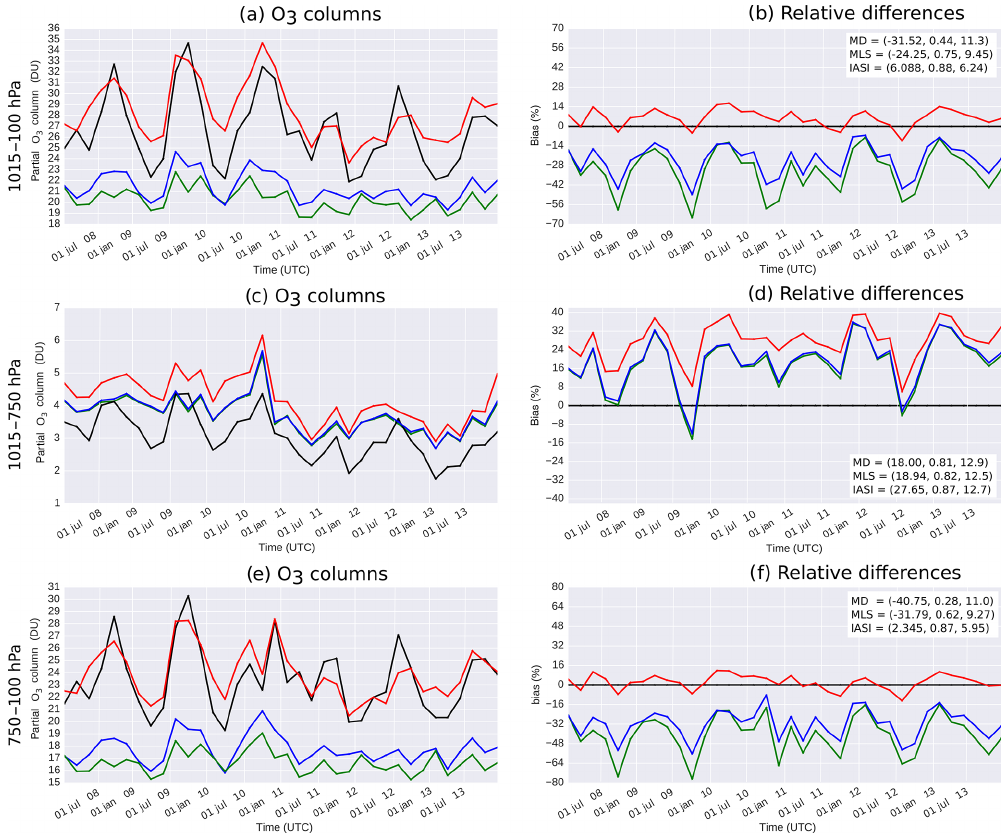
Figure 3. Time series of partial ozone columns ( a , c , e , in DU) from the IASI-a (red curves), the MLS-a (blue curve), and the DM (green curve) plotted versus several stations measurements from WOUDC (black curves). Data are 2-month averages over the area 15 ◦ S–15 ◦ N and 180 ◦ W–180 ◦ E for (a) , the ozone column between 1015 and 100hPa (b) , the boundary layer (1015–750hPa) (c) , (d) and the free troposphere (750–100hPa) (e) , (f) . Biases in percentages are shown in (a) , (c) and (e) . Mean biases, correlation coefficients and standard deviations are also given (between brackets in b , d and f ). Table 1. Ozonesonde stations at tropical latitudes between 70 ◦ E and 110 ◦ W.